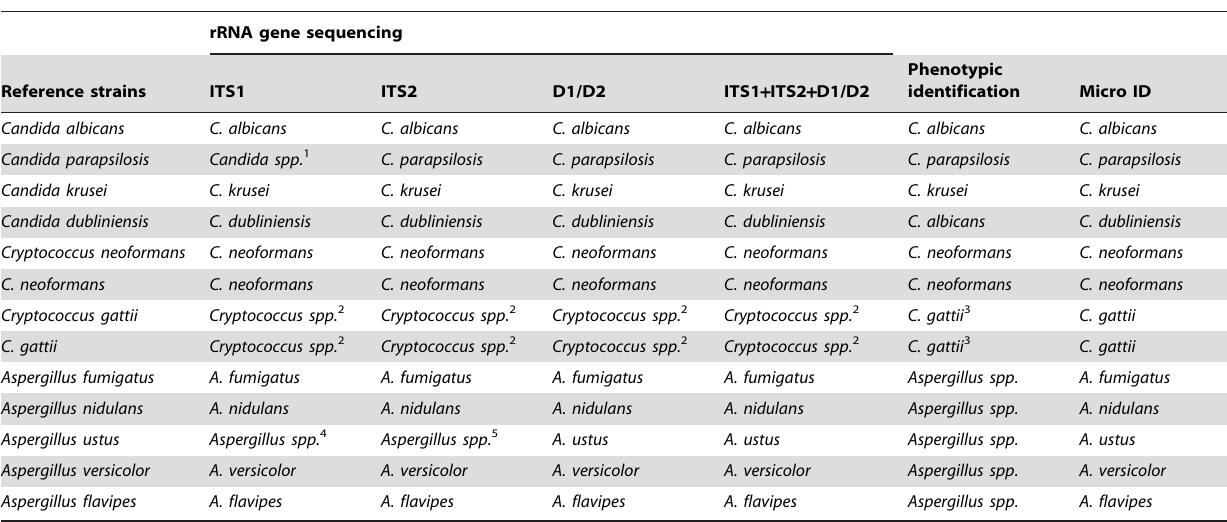
Table 3. Identification of reference strains (n=